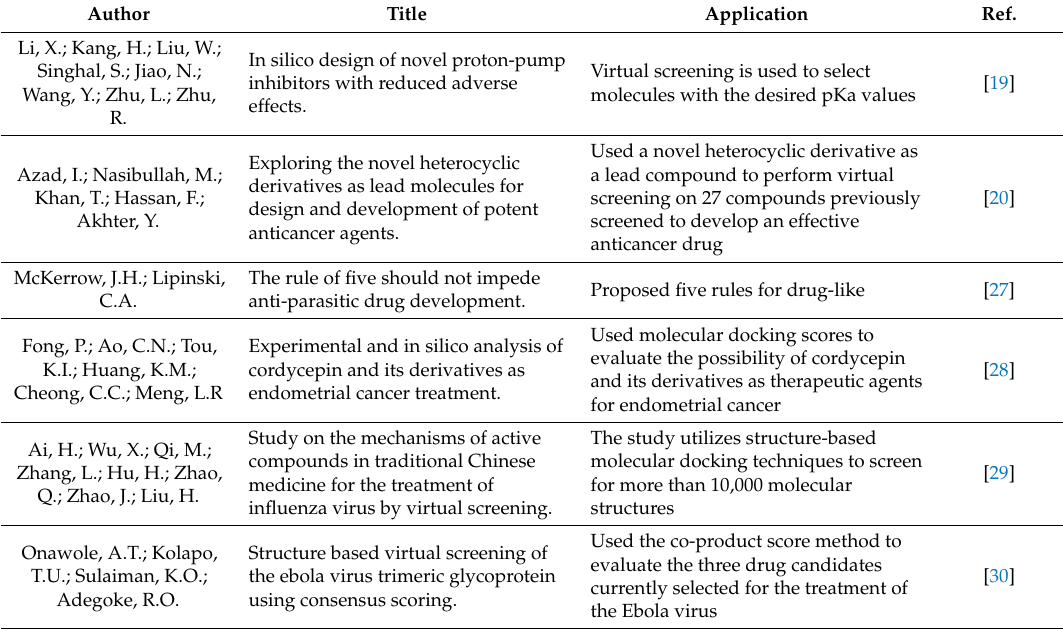
Table 1. The application examples of virtual screening technology.